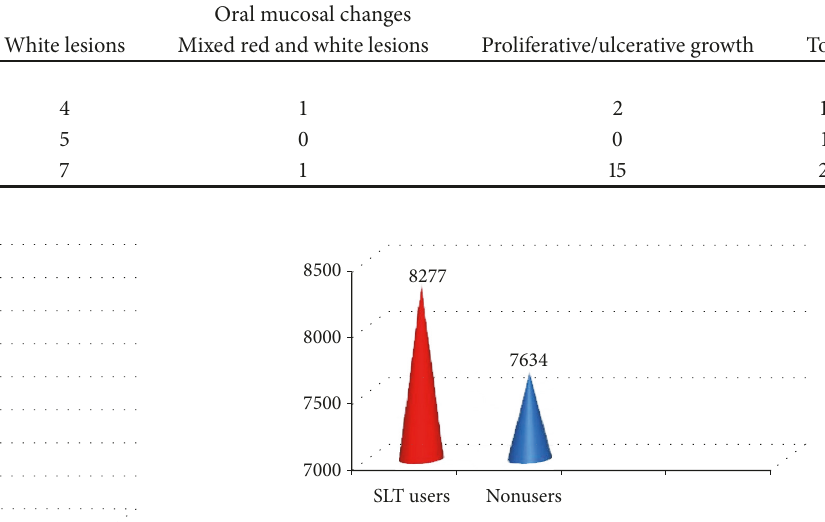
Figure 2: Comparison of TLC between SLT users (exposed) and